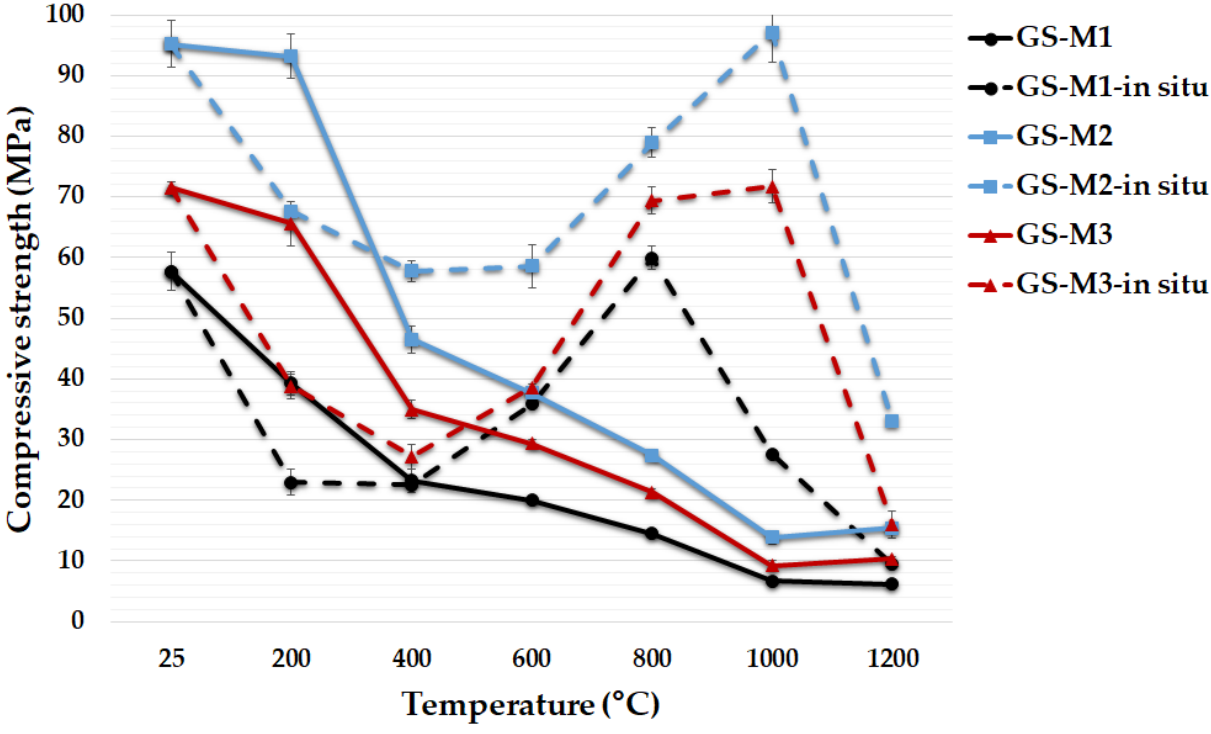
Figure 10. Compressive strength of the geopolymer composites with different types of aluminosili- cates at laboratory temperature, after exposure up to 1200 °C and in situ temperature from 25 °C to 1200 °C.